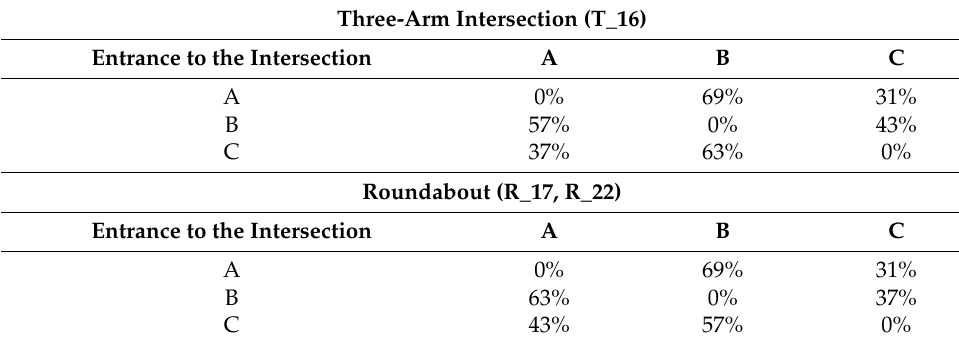
Table 5. Traffic routing matrix through the intersections (three-arm intersection, roundabout) in Žilina City.